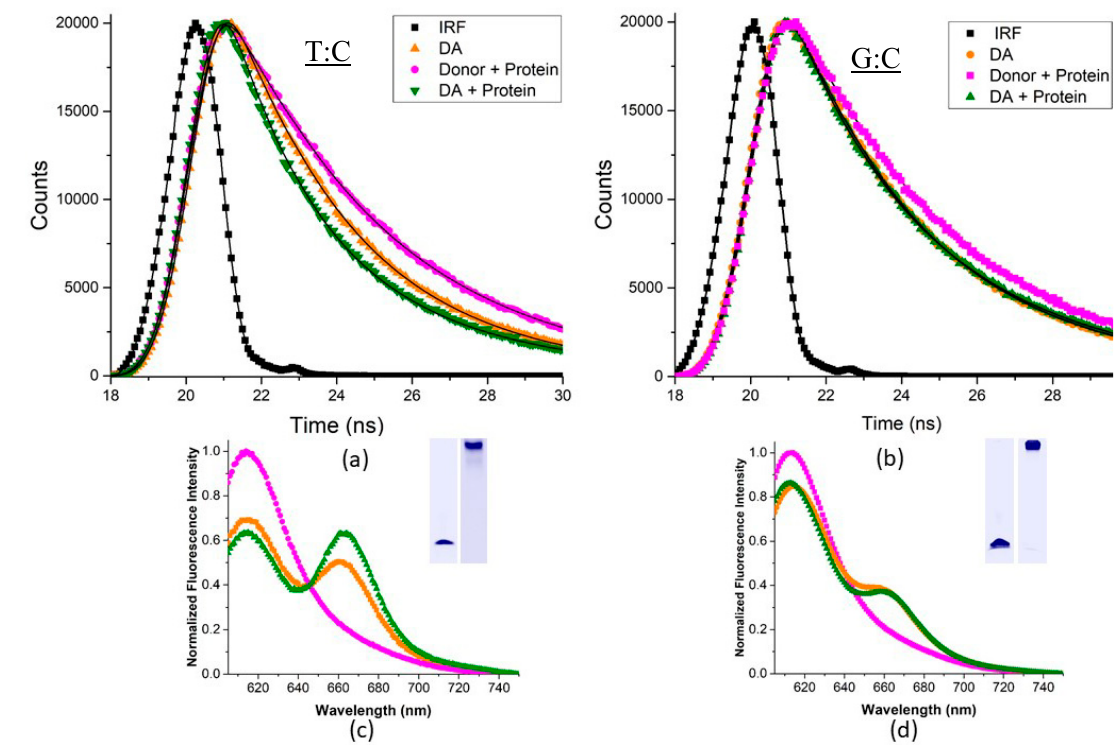
Figure 7. Time-resolved lifetime decays of mismatched substrates. Shorter lifetimes are detected in the presence of protein implying an increase in FRET efficiency for mismatched substrates such as ( a ) T:C mismatched duplex, but not ( b ) G:C duplex DNA upon Msh2–Msh6 binding. ( c , d ): Steady-state spectra of the same samples post irradiation show similar trends in FRET efficiency change. The samples were also run on a gel (inset) to show the formation of the protein-DNA complex and lack of sample degradation. 200 nM labeled DNA was used with sufficient Msh2–Msh6 protein to ensure > 90% protein-bound DNA. The instrument response function is shown in black. Decays were collected using an excitation wavelength of 590 nm and monitoring emission at 620 nm.